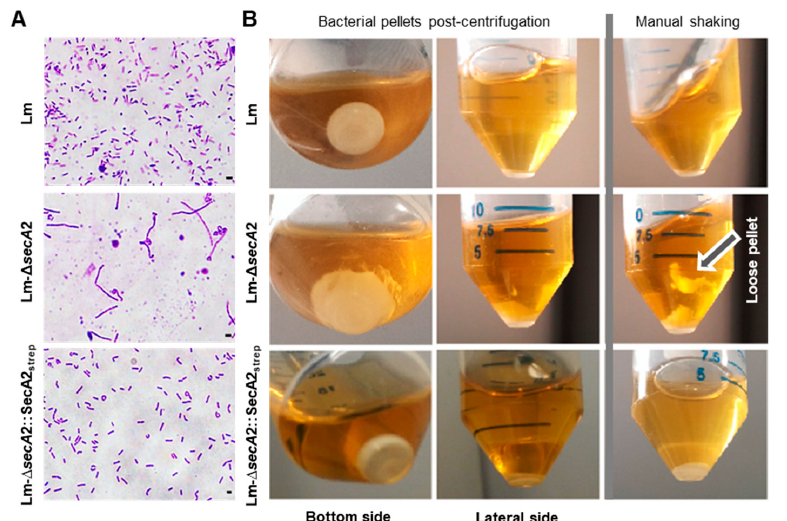
Figure 1. ( A ) Assessment of SecA2 functionality in Lm- ∆ secA 2::SecA2 strep ( Lm = L. monocytogenes ).